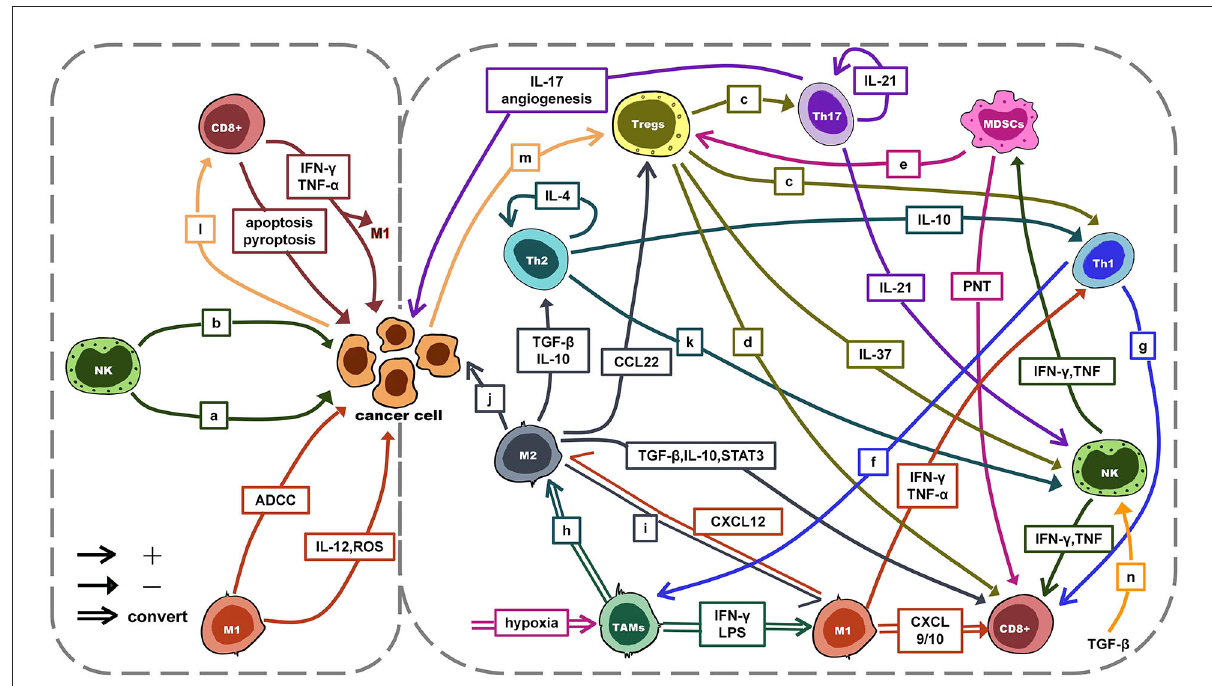
FIGURE2 The interaction between antitumor cells, immunosuppressive cells and tumor cells. a: ADCC/apoptosis/pyroptosis; b: IFN- γ ,TNF- α : anti-proliferative, anti-angiogenic, pro-apoptosis; c: TGF- β , IL-10, IL-35, GZMB, perforin; d: TGF- β , IL-10, IL-35, GZMB, perforin, CTLA-4, PD-1; e: PD-L1 ↑ , HIF-1 α ↑ , TGF- β , IL-10, CCL4, CCL5; f: IFN- γ : induce activation; g: IFN- γ , LT α , IL-2; h: M2a: IL-4,IL-13; M2b: immune complex with IL-1 β /LPS; M2c: IL-10,TGF- β ; IL-6,LIF; i: dual blockade of PI3K- γ pathway and CSF-1/CSF-1R; CD40 agonist; j: pro-proliferative, pro-invasion, pro-metastasis, angiogenesis; k: IL-4 → IFN- γ ↓ ; l: MHCI ↓→ escape; m: PD-1/PD-L1 → hijack; miR-214 → proliferation; n: cytokine ↓ ; degranulation ↓ ; metabolism ↓ ; mTOR signal ↓ . ADCC, antibody-dependent cell-mediated cytotoxicity; TGF- β , transforming growth factor- β ; CTLA-4, cytotoxic T lymphocyte-associated antigen-4; LIF, leukemia inhibitory; CSF-1, colony-stimulating factor 1 factor; mTOR, mammalian target of